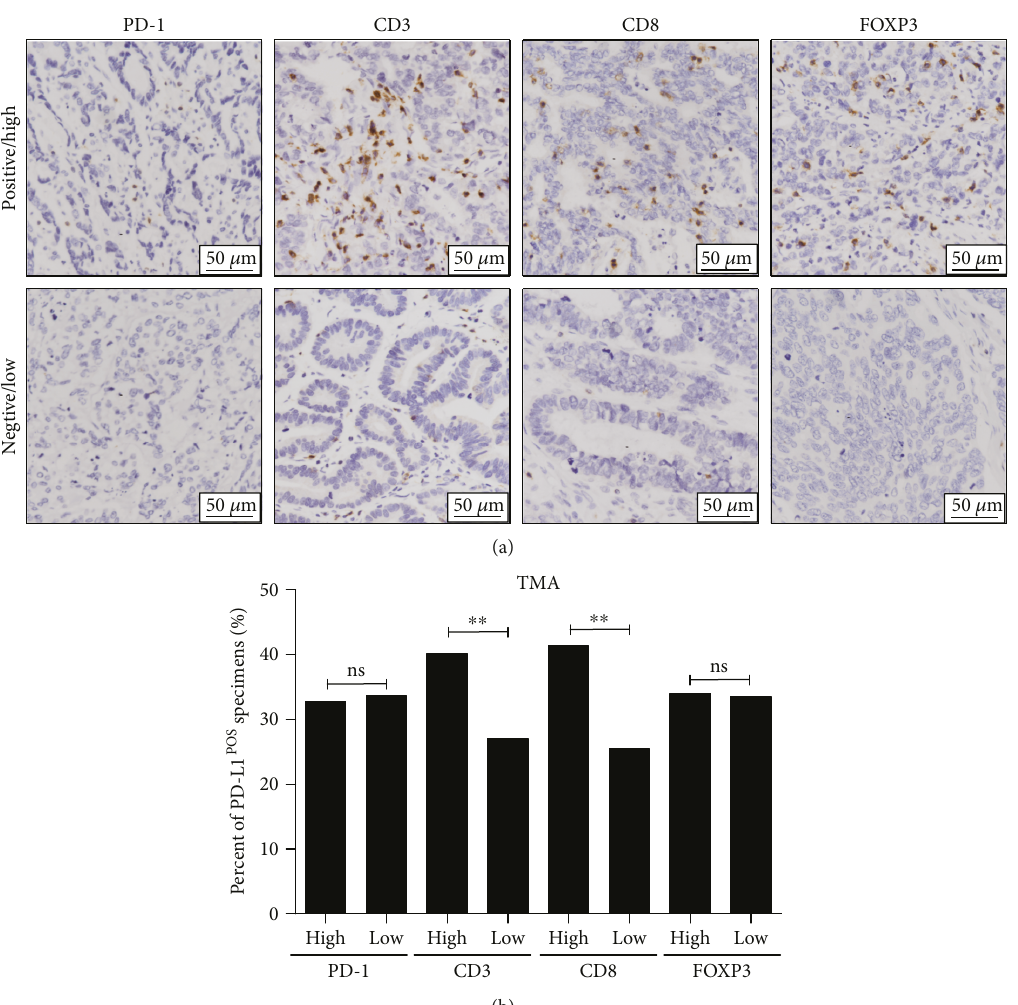
Figure 2: PD-1 + immune cell and T cell in fi ltration in AGCs. (a) Representative samples of IHC staining of PD-1, CD3, CD8, and FOXP3, including high and low in fi ltration for each marker, are presented. (b) The percent of tumor PD-L1-positive specimens in the high and low expression groups of PD-1, CD3, CD8, and FOXP3. ∗∗ P < 0 01 ; ns: no statistical signi fi